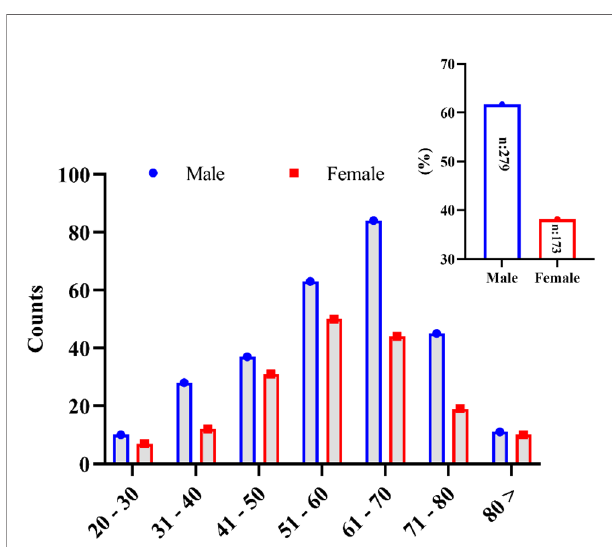
FIGURE 1 | Gender-wise distribution of the SARS-CoV-2-infected patients in the different age groups studied in this